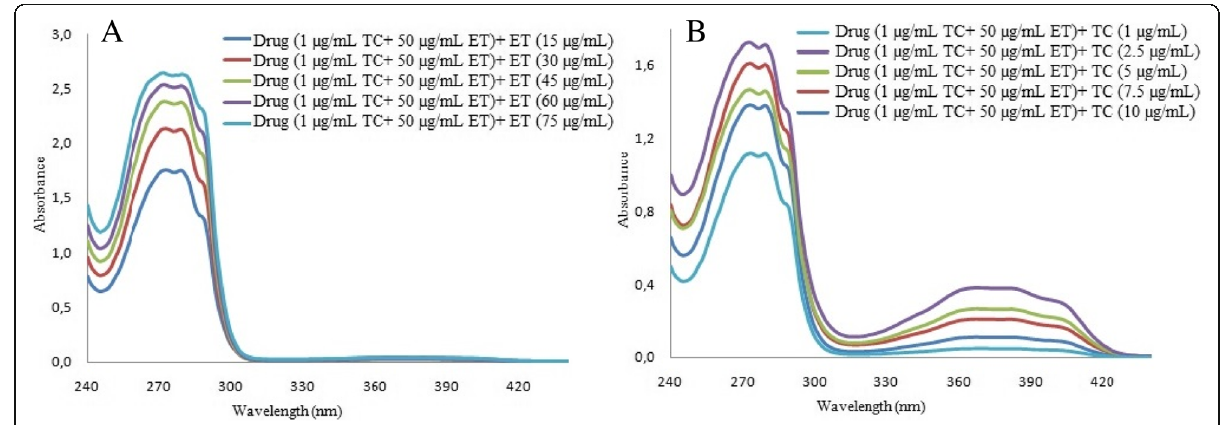
Fig. 2 UV absorption spectra of the standard solutions added to the pharmaceutical preparation for ET ( a ) and TC ( b